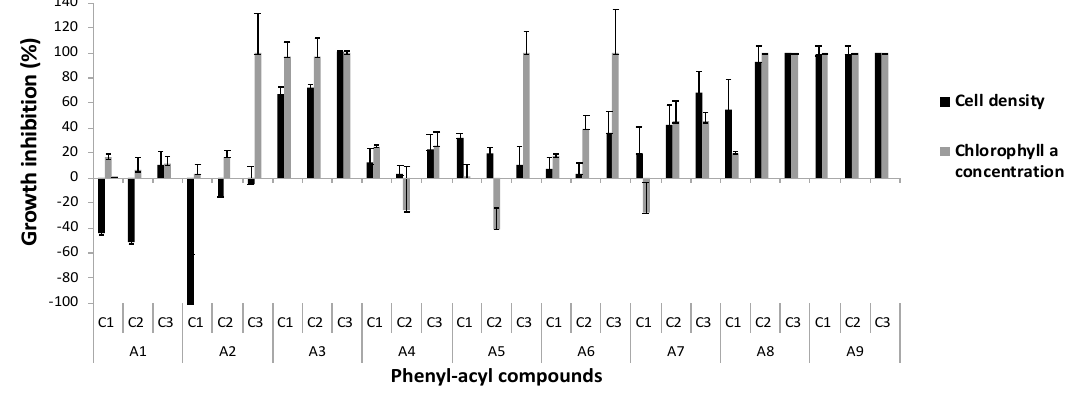
Figure 2. The effects of phenyl-acyl compounds on the growth of Microcystis aeruginosa Kützing at 72 h of growth according to cell density measurements and chlorophyll a concentration. 3,5-dimethoxybenzoic acid (A1), syringic acid (A2), caffeic acid (A3), 3-methoxyphenylacetic acid (A4), 2´-hydroxycinnamic acid (A5), 4-hydroxyphenylacetic acid (A6), vanillin (A7), eugenol (A8), and, for copper sulfate, a Cu(SO)4 control (A9). The concentrations assayed were: 100 mg/L (C3), 50 mg/L (C2), and 25 mg/L (C1). The letters and numbers refer to the structures shown in Figure 1.